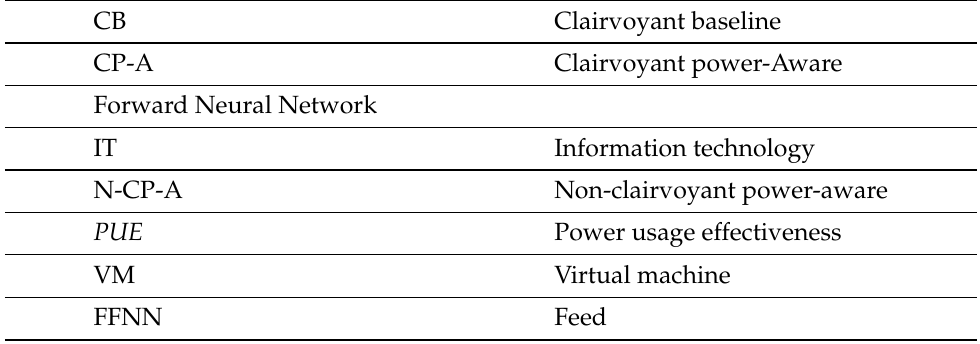
Table 2. List of Abbreviations.